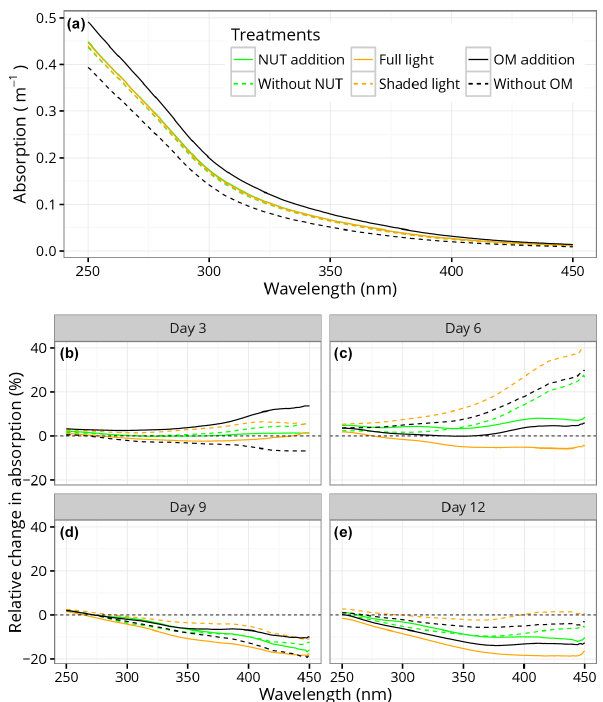
Figure 3. Spectral absorption curves of CDOM in the different mesocosms units for the initial day (a) and the relative changes for each sampling day compared with the initial day (day 3: b ; day 6: c ; day 9: d ; day 12: e ).